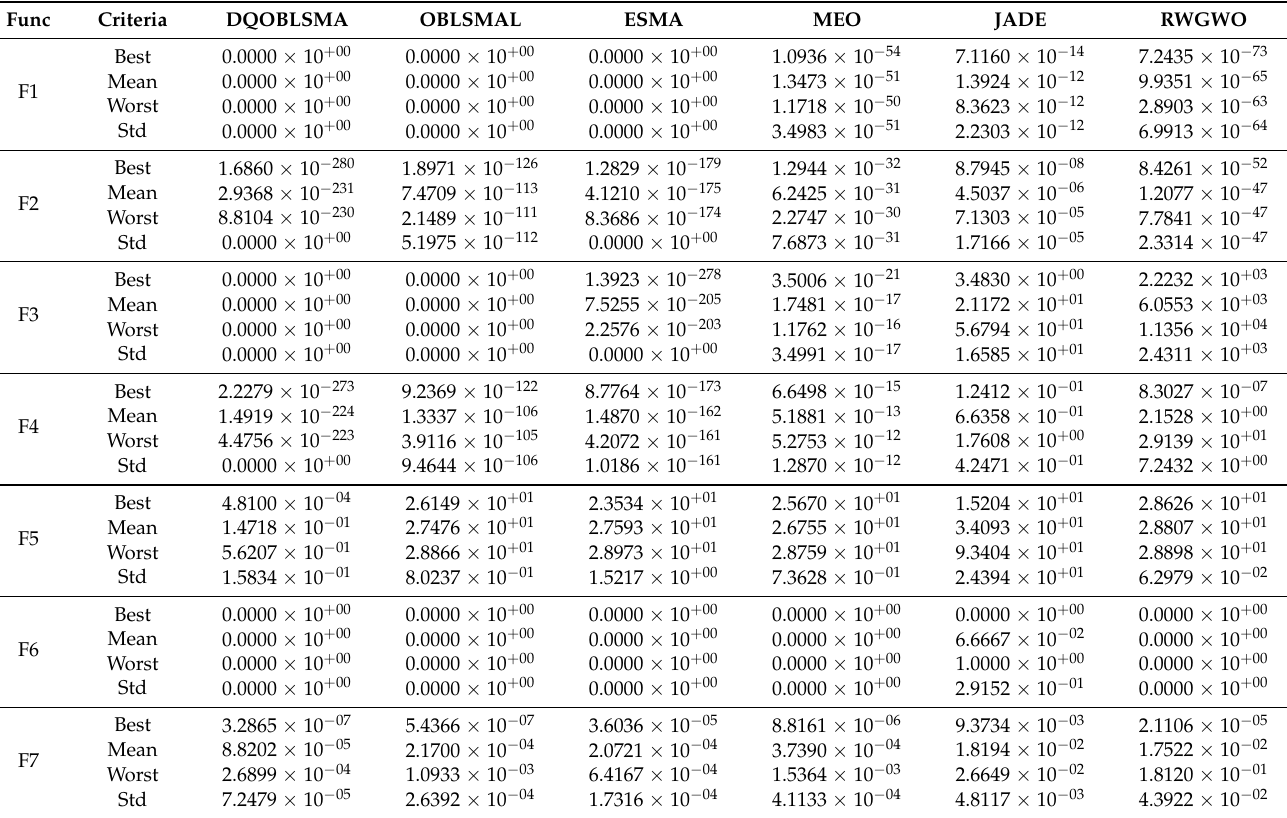
Table 6. Results of unimodal benchmark test functions.